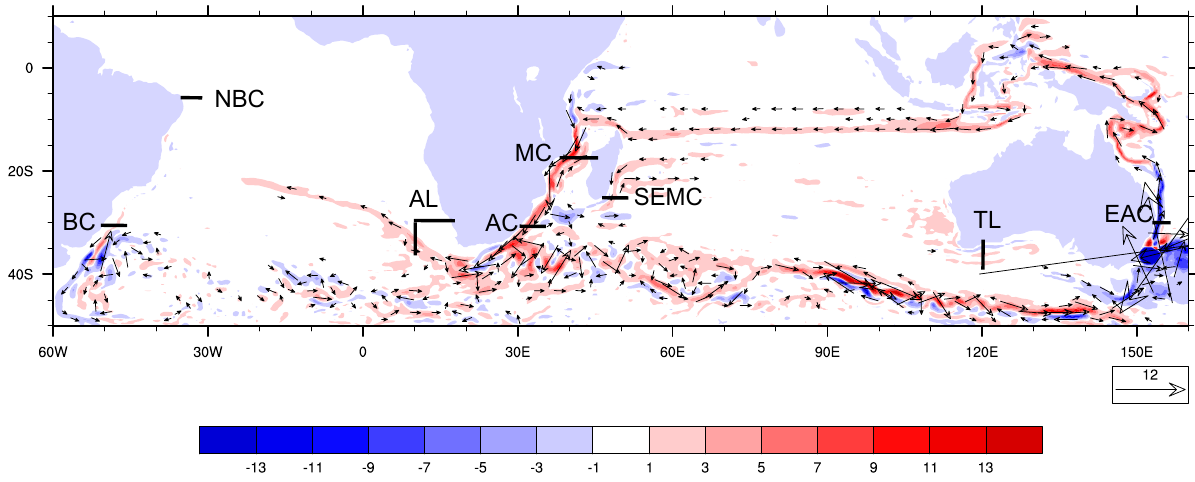
Fig. 6. Velocity difference (arrows, with the length of the arrow corresponding to 12cms − 1 indicated) between POP CTRL and POP NoITF. The difference of the magnitude in cms − 1 is shown in color. Velocities are vertically averaged from the surface to the depth of 1500m and temporally over the last 40yr of the simulations. Sections used for Table 2 are also shown here (EAC: East Australian Current at 30 ◦ S, TL: Tasman Leakage, NBC: North Brazil Current at 6 ◦ S, SEMC: South East Madagascar Current, BC: Brazil Current at 32 ◦ S, AL: Agulhas leakage, AC: Agulhas Current at 32 ◦ S, MC: Mozambique